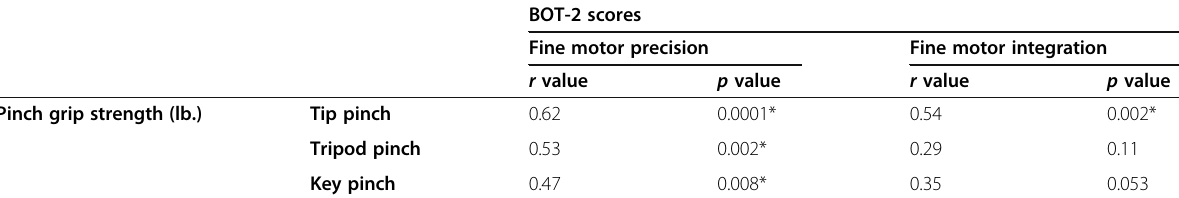
Table 3 Correlation between pinch grip strength and BOT-2 of the dominant hand in children with diplegia